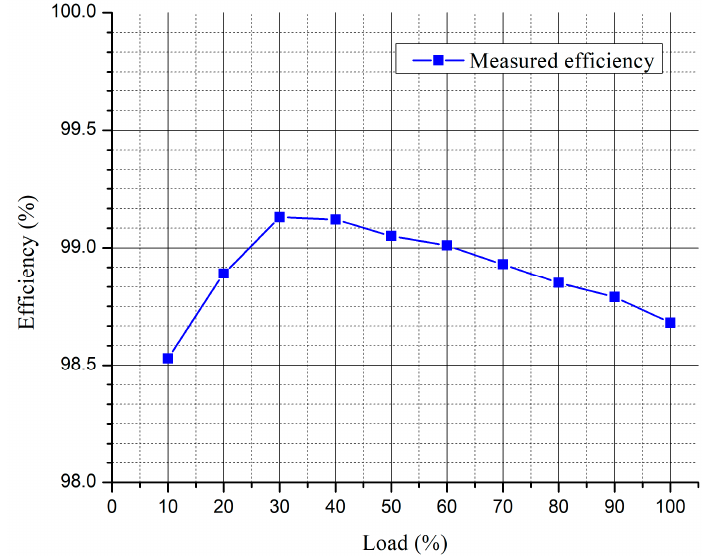
Figure 13. The efficiency curve with the overall load range of 2.6 kW at high line condition 230 VAC.